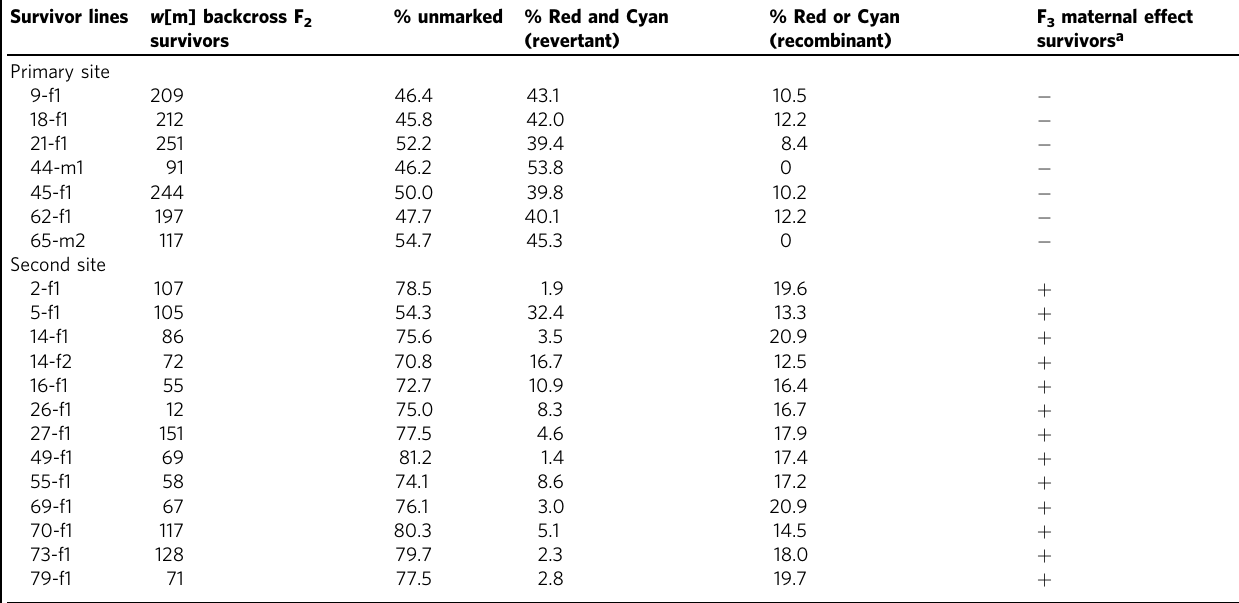
Table 2 Tet-off revertant lethal F 2 and F 3 survivors reared on Tet-free diet. Survivor lines w [m] backcross F 2 survivors